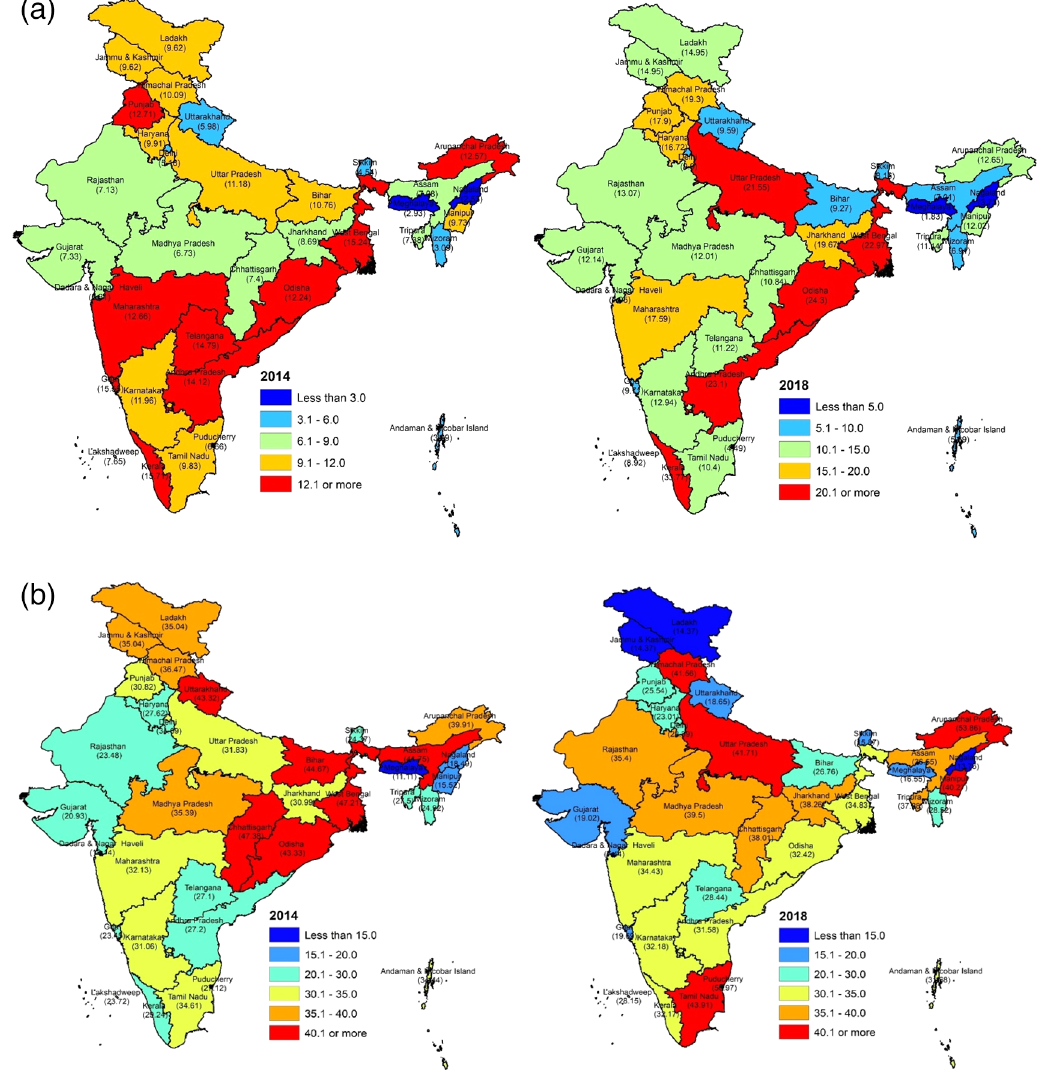
Figure 3. a:Map showingincidenceof CHEbystates, 2014and 2018.b: Mapshowing intensityof CHEby states, 2014 and